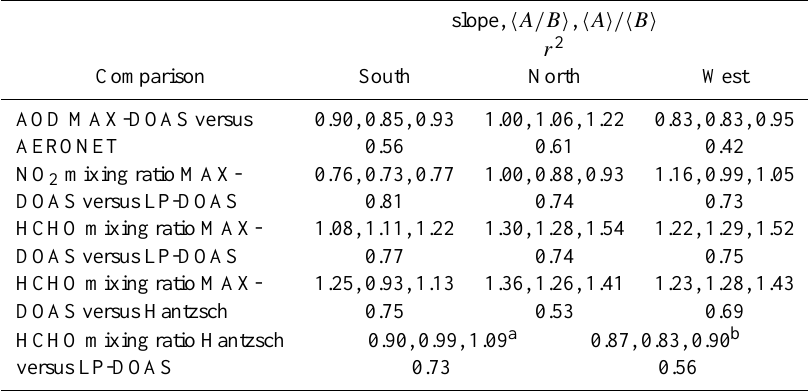
Table 4. Comparison results of MAX-DOAS observations and independent measurements for clear sky observations from 12 September to 26 September (see text). Besides the slopes of the fitted regression line, the mean value of the individual ratios h A/B i the ratio of the mean values h A i / h B i (see Eqs. 20 and 21) and the coefficient of determination, r 2 , are shown. Also included are the comparison results for the HCHO mixing ratios from LP-DOAS versus Hantzsch (bottom).